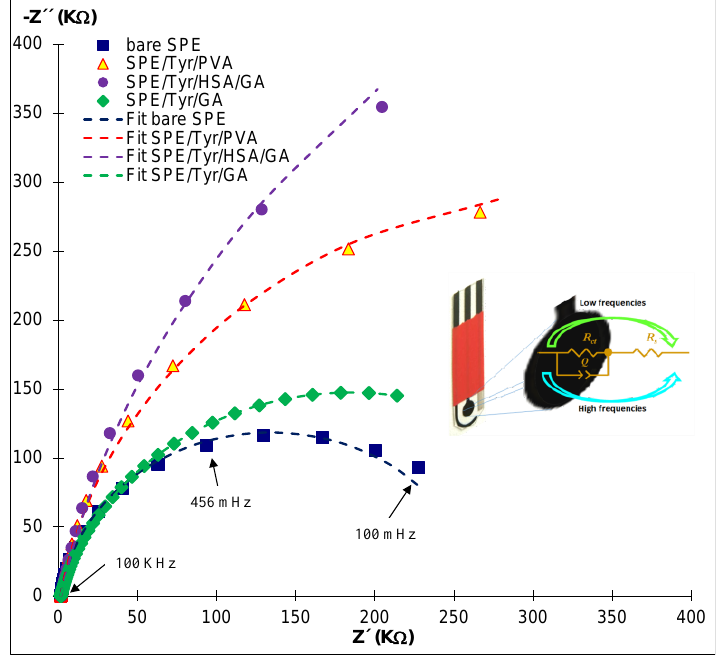
Figure 5. Comparison of the experimental Nyquist diagrams (dots) recorded using each biosensor immersed in 0.1 M phosphate’s buffer at pH 7.00 ± 0.01, with 0.1 M KCl, 1 mM Fe ( CN ) 63  /4  at (30.0 ± 0.5) °C, with the corresponding (broken line) obtained by fitting of the Randles’ circuit, see the inset, to the experimental data using Zview software. With the best fit parameters the data shown in Table 2 were obtained.